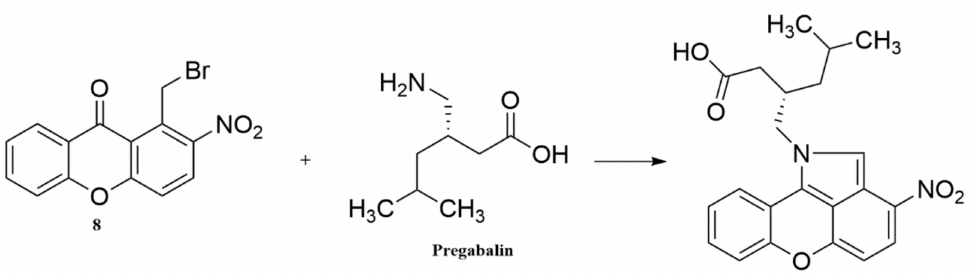
Figure 2. Derivatization reaction of pregabalin with the novel xanthone analogue.